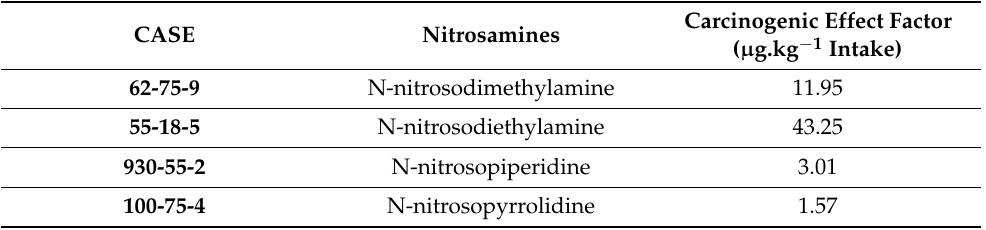
Table 2. Factor of the carcinogenic effects of nitrosamines (via ingestion) according to USEtox 1.01 [67,68].